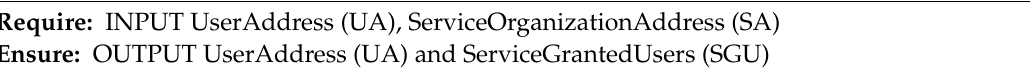
Algorithm 3 Algorithm for ServiceRequest